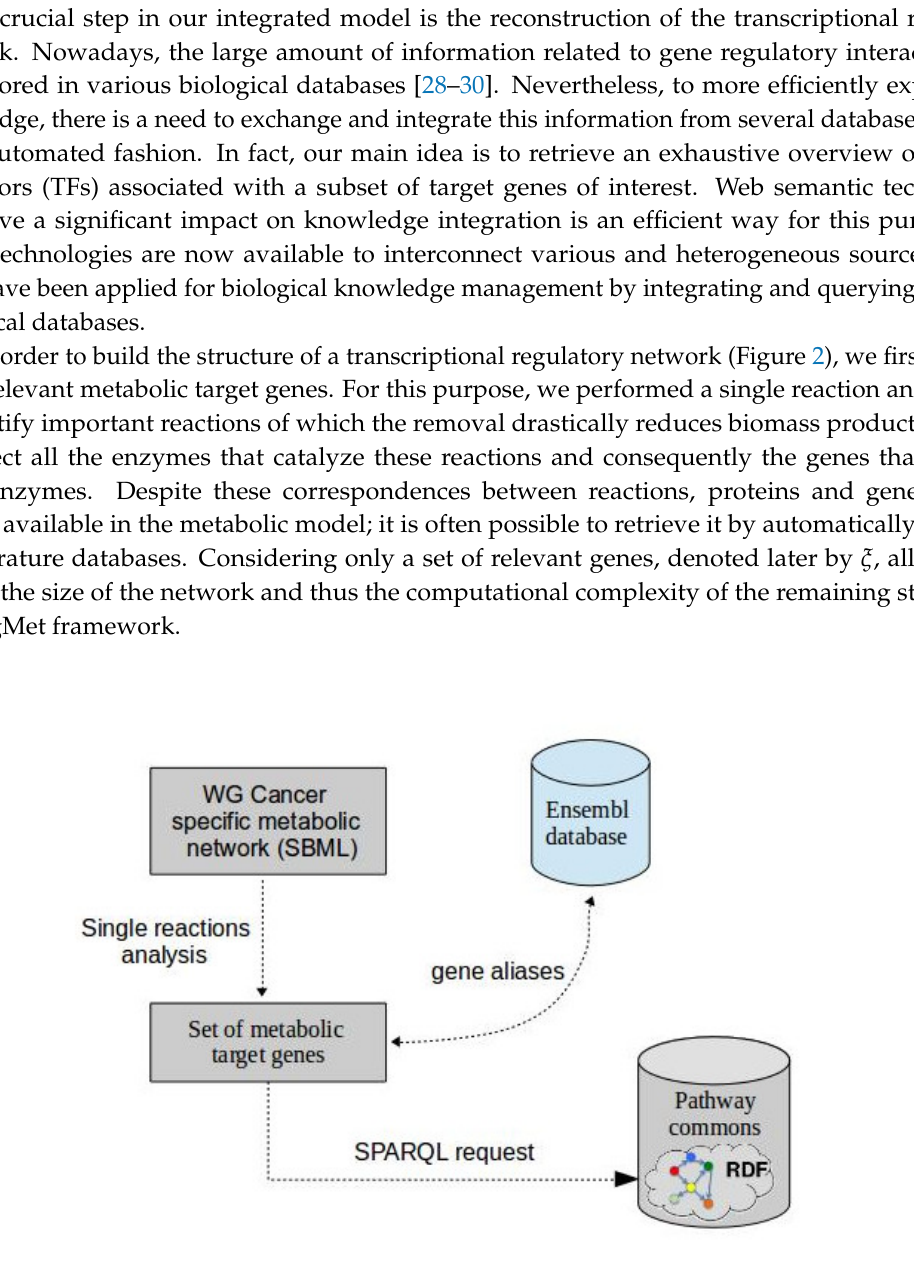
Figure 2. Overview of the process used to automatic retrieval of regulatory genes using web semantic